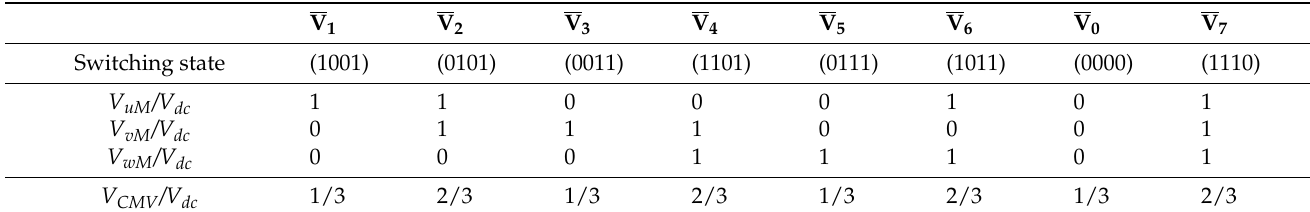
Table 1. The H8 transformerless inverter